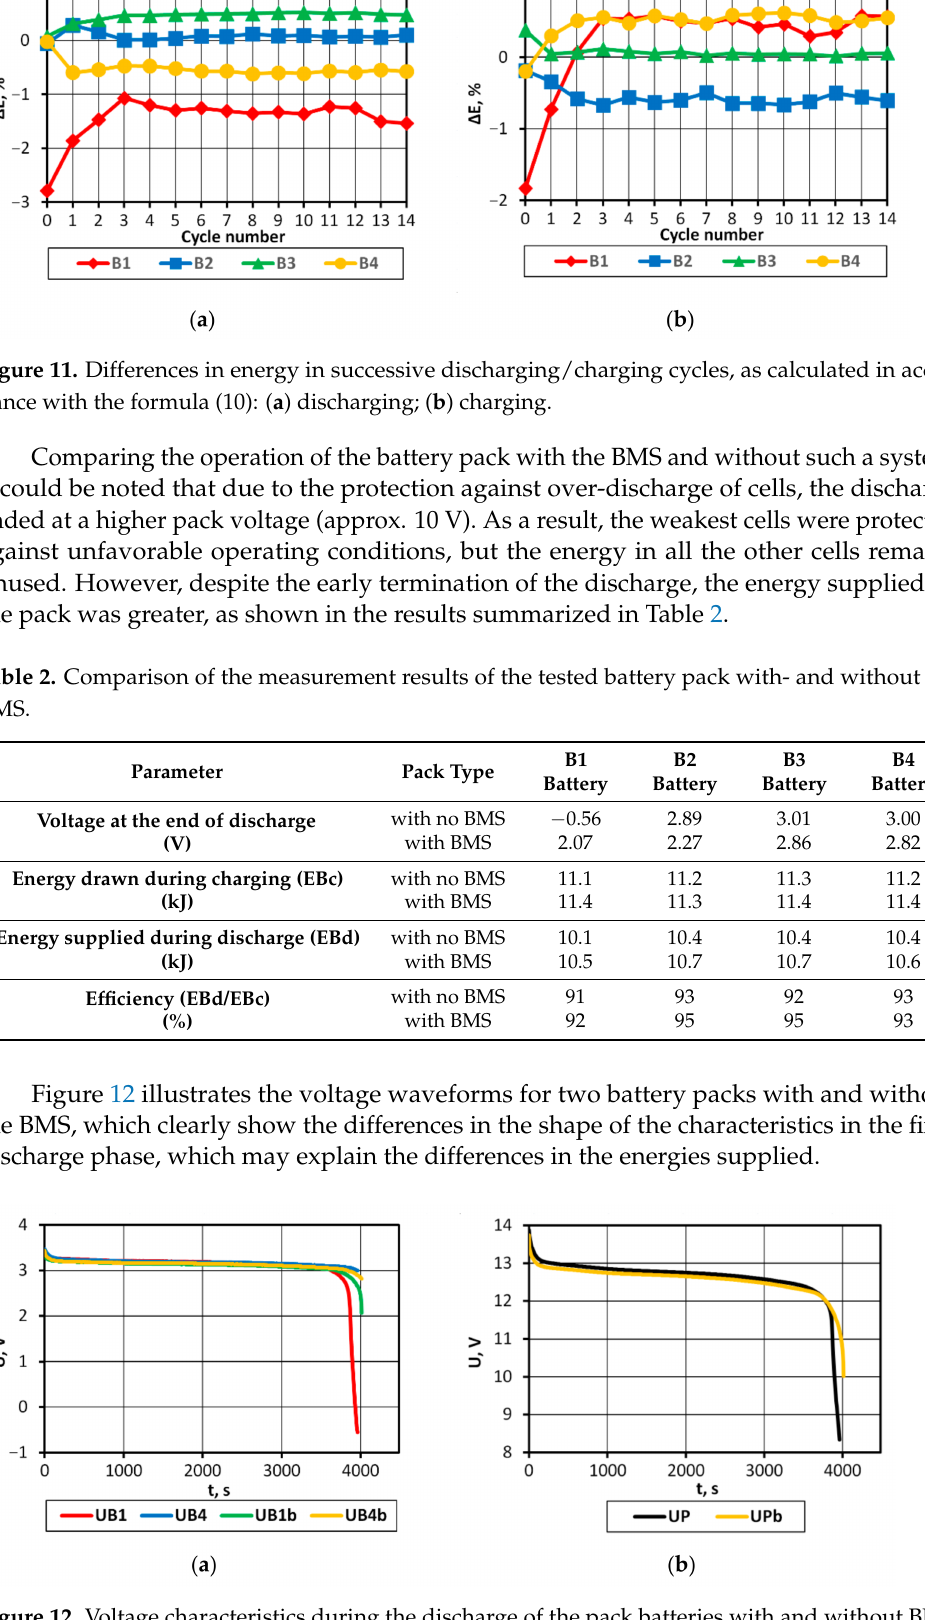
Figure 12. Voltage characteristics during the discharge of the pack batteries with and without BMS: ( a ) B1 and B4 (UB1, UB4—without BMS; UB1b, UB4b—with BMS) battery voltage; ( b ) pack voltage (UP—without BMS; UPb—with